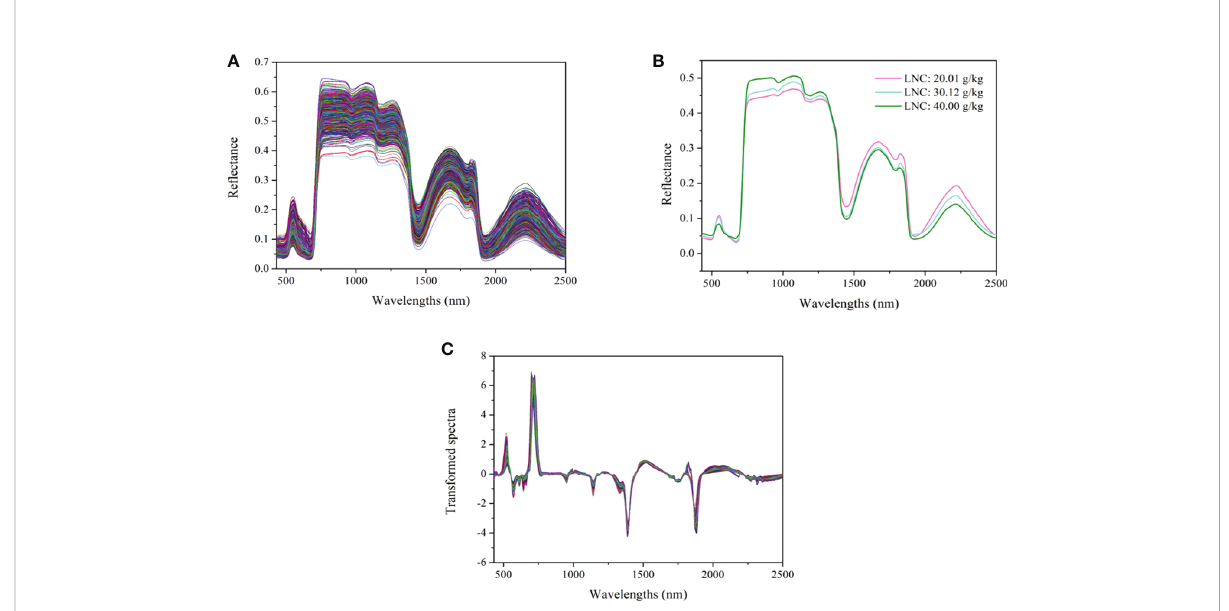
FIGURE 4 Spectra of cotton leaves: (A) the spectra of all the cotton leaves, (B) the spectra of leaves with different LNC, (C) the spectra transformed by FD